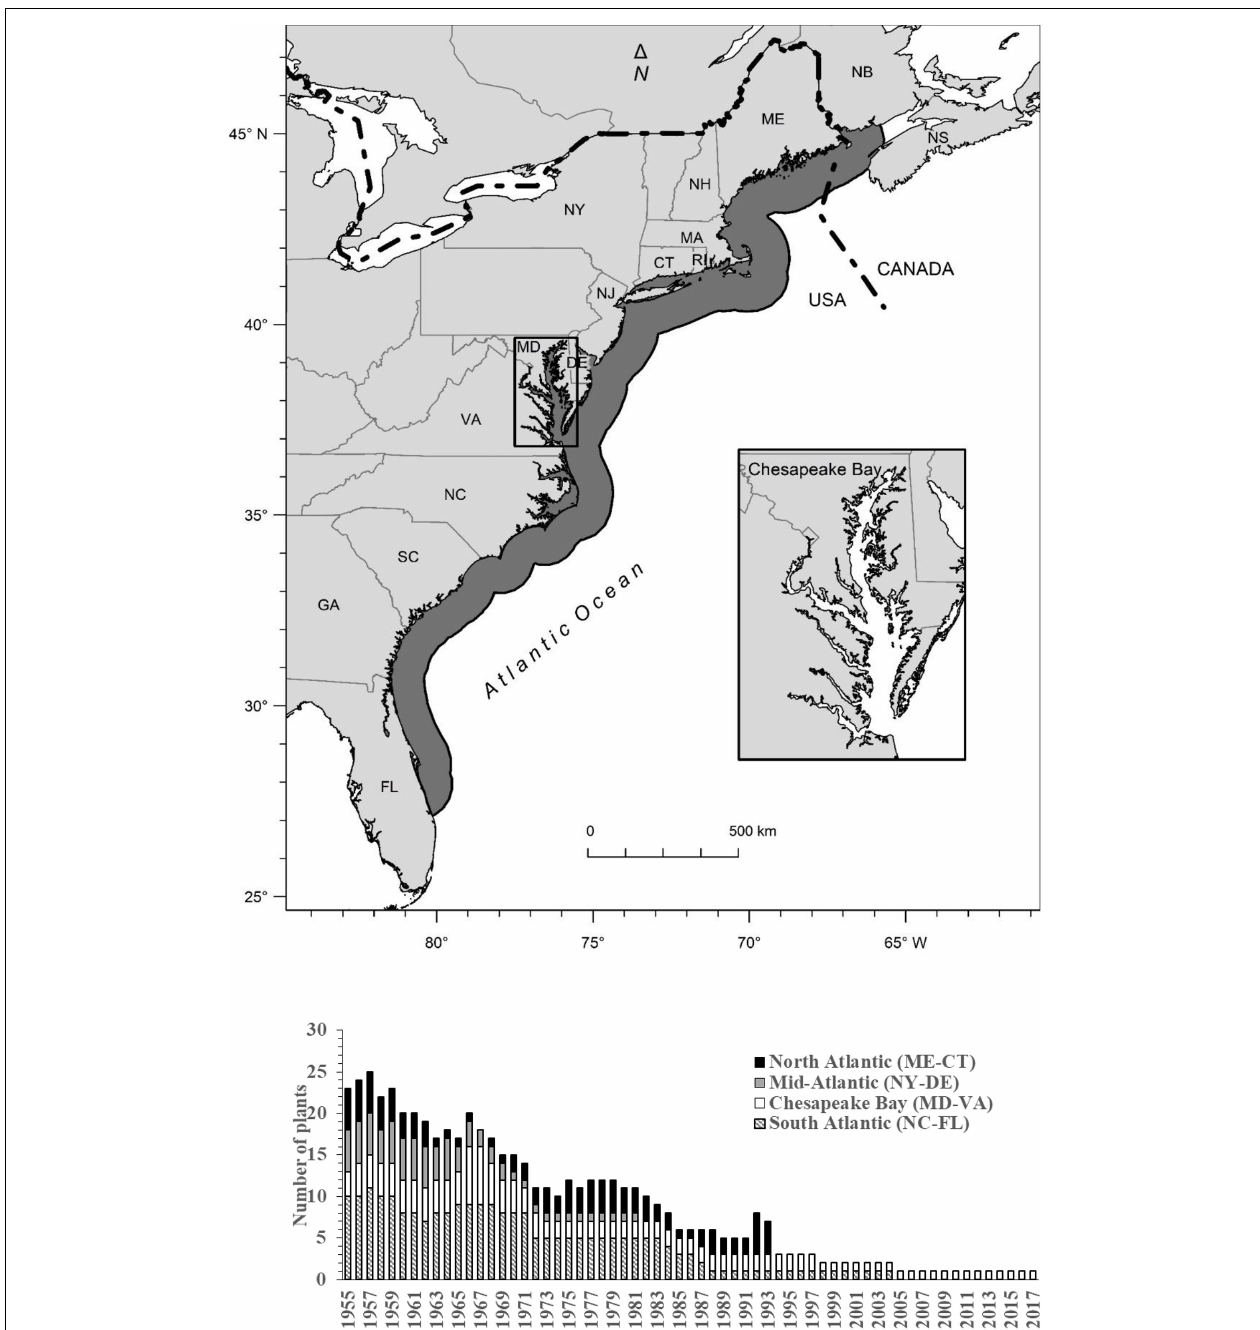
FIGURE 1 | Map of the range of Atlantic menhaden from Nova Scotia, Canada, along the nearshore and coastal waters of the United States Atlantic coast to Florida, top, and the number of reduction plants in operation in the United States by region through time, bottom (Source: NOAA Beaufort).